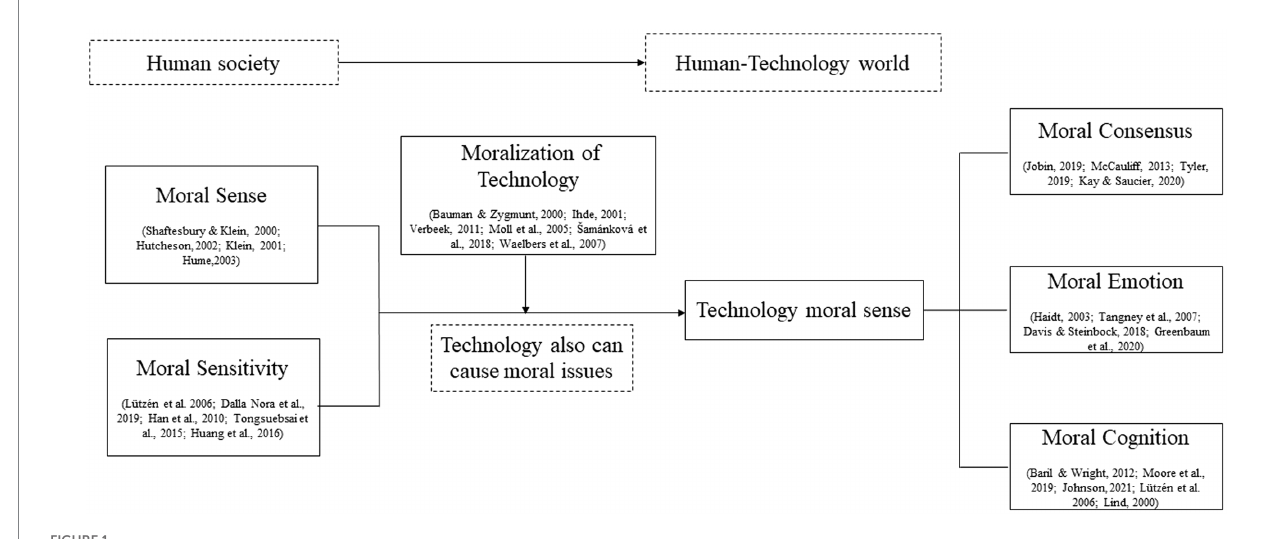
FIGURE 1 The concept evolution